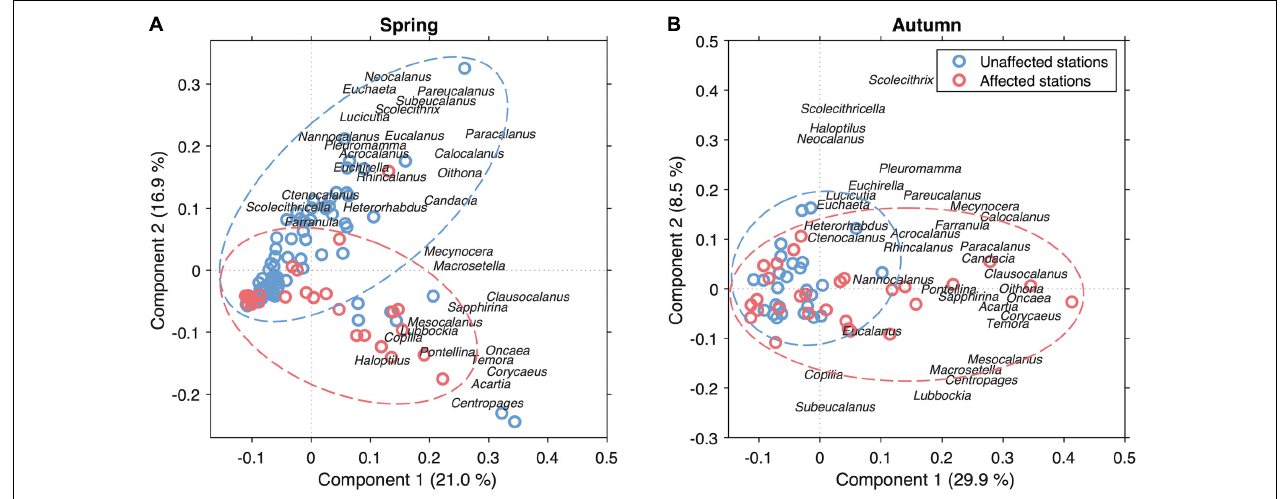
FIGURE 10 | Principal Component Analysis of the dominant copepod genera in the stations ( > 10%) affected and unaffected by the volcanic influence in all the stations carried out during spring (A) and autumn cruises (B)